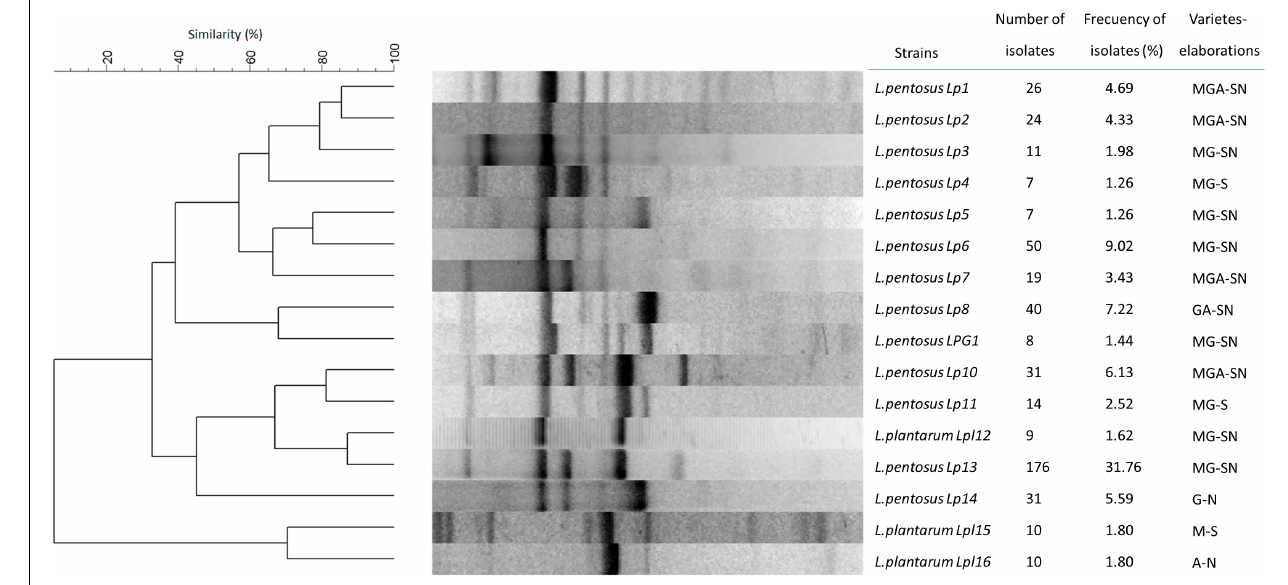
FIGURE 1 | Dendrogram obtained for the rep-PCR profiles obtained with GTG 5 primer for the predominant ( > 1% frequency) LAB genotypes randomly isolated from biofilms of different table olive processing. The dendrogram was built after selecting a representative genotype from each cluster by bioinformatics analysis with the Bionumerics 6.6 software package. M, G, and A stand for the type of olive cultivar (Manzanilla, Gordal, and Aloreña, respectively), while S and N refer to the type of elaboration (Spanish-Style or